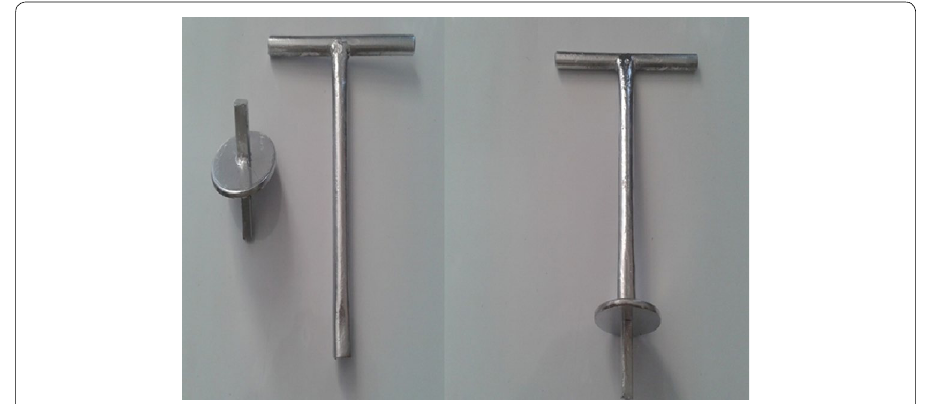
Fig. 6 Tools of helical pile installation in the soil